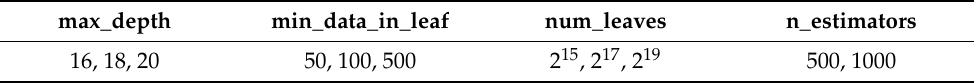
Table 1. Various combinations of hyperparameters tested to optimize the proposed LightGBM